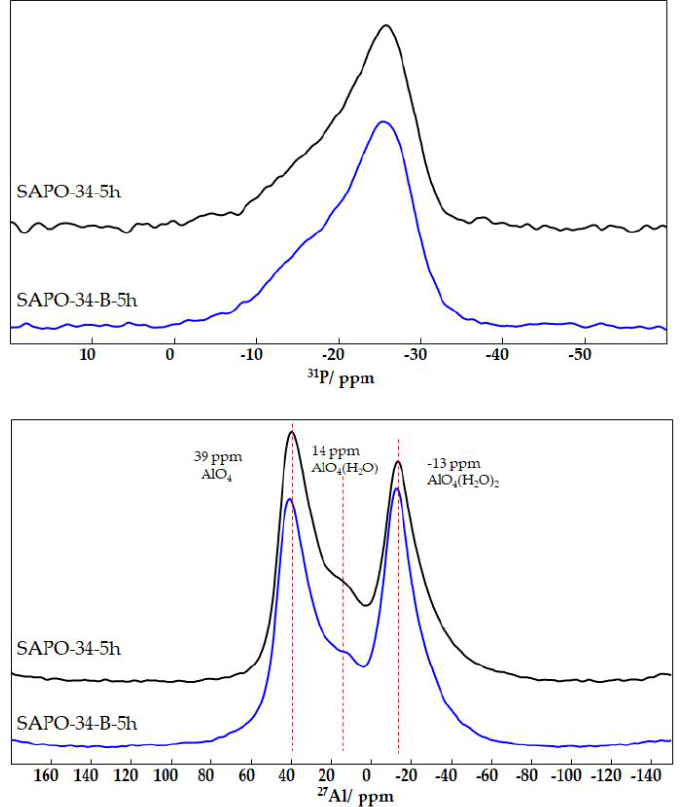
Figure 4. 31 P (top) and 27 Al (down) NMR spectra of SAPO-34 samples synthesized from AIP (SAPO- 34 − 5h) and boehmite (SAPO-34 − B − 5h).